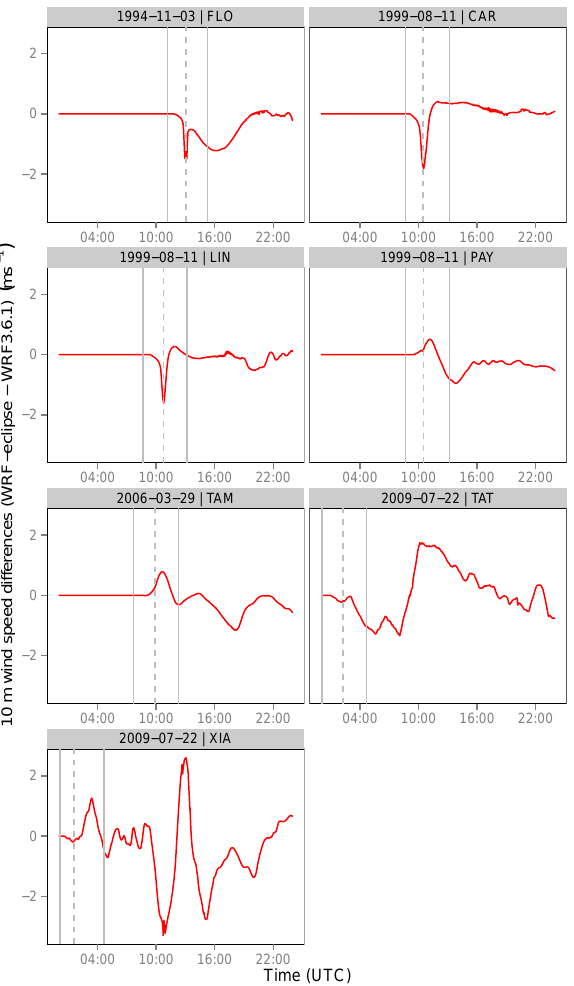
Figure 7. Wind direction at 10m for each episode and site. Values for wind speeds below 1ms − 1 are not included. The first and sec- ond vertical gray solid lines indicate the time of FCTD and LCTD, respectively. The dashed vertical gray line shows the time of maxi- mum obscuration. All results are expressed with 1min time resolu-